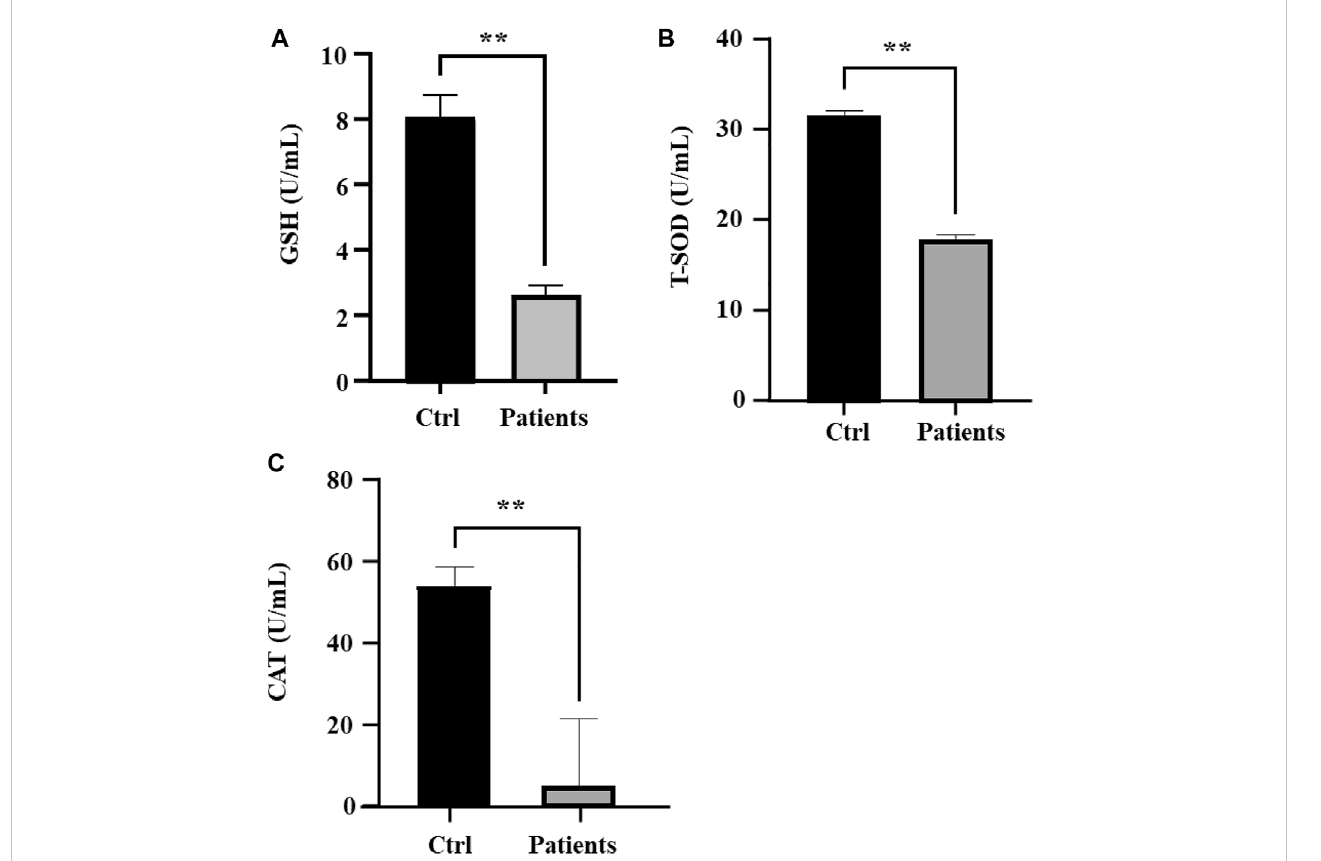
Analysis of oxidative stress in human spermatozoa. (A) Glutathione (GSH), (B) Total superoxide dismutase (T-SOD), (C) Catalase (CAT). All data are displayed as means ± s.e.m. (* p < 0.05, ** p < 0.01; Student ’ s t